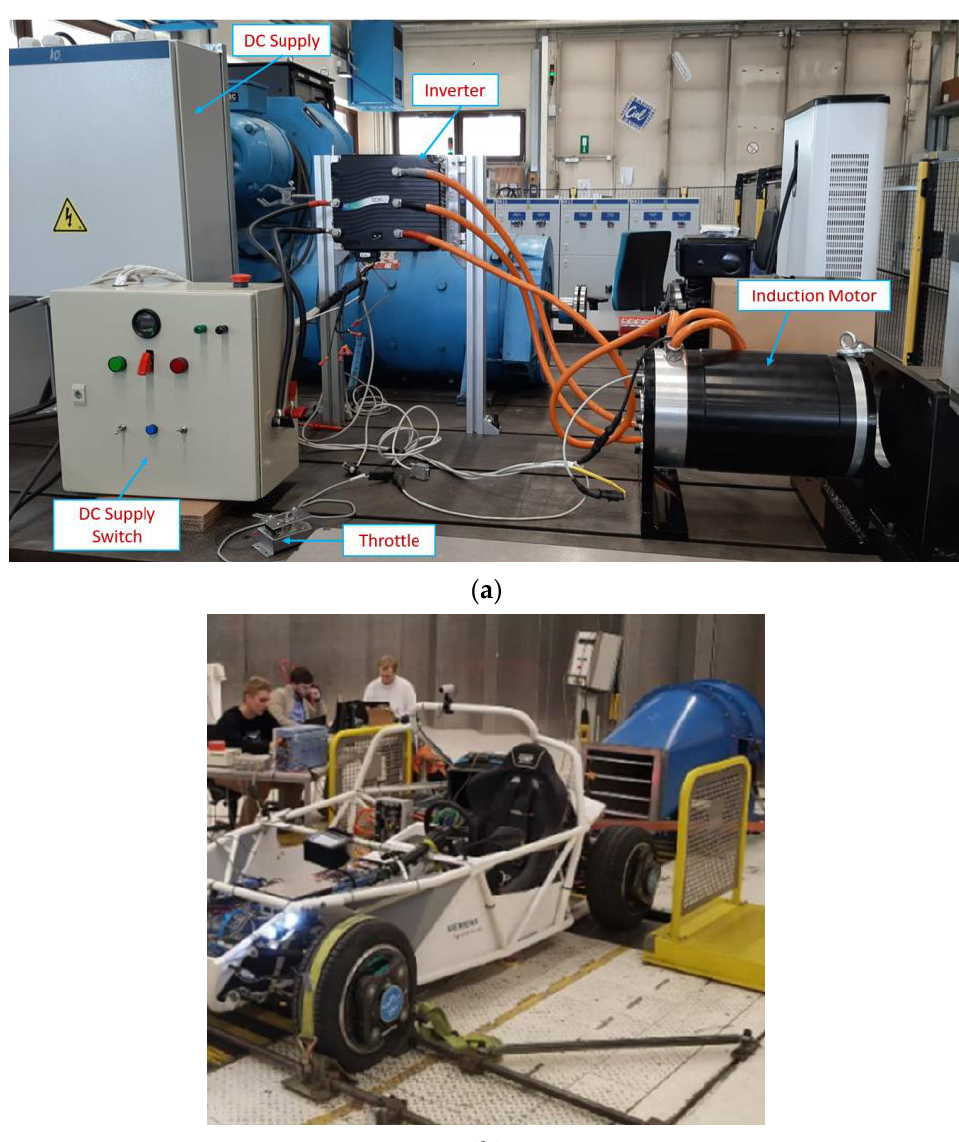
Figure 19. Installed setup; inside current sensors ( a ) and Simrod EV on chassis dynamometer ( b ).